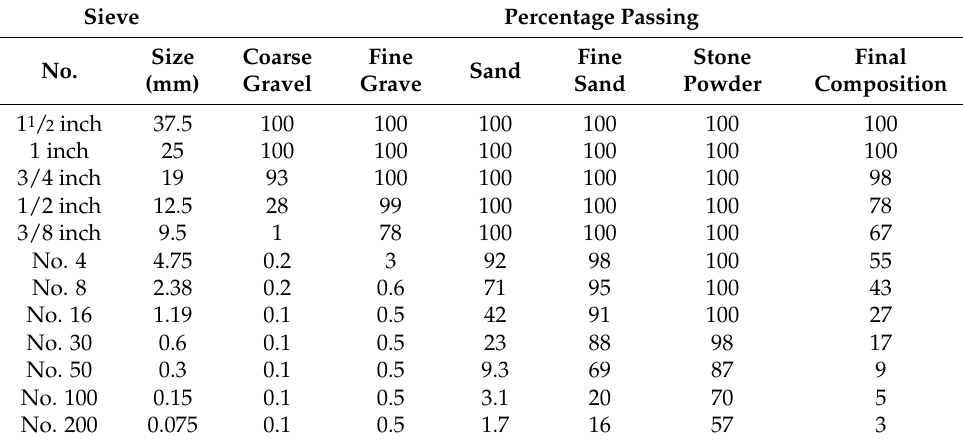
Table A1. Gradation test